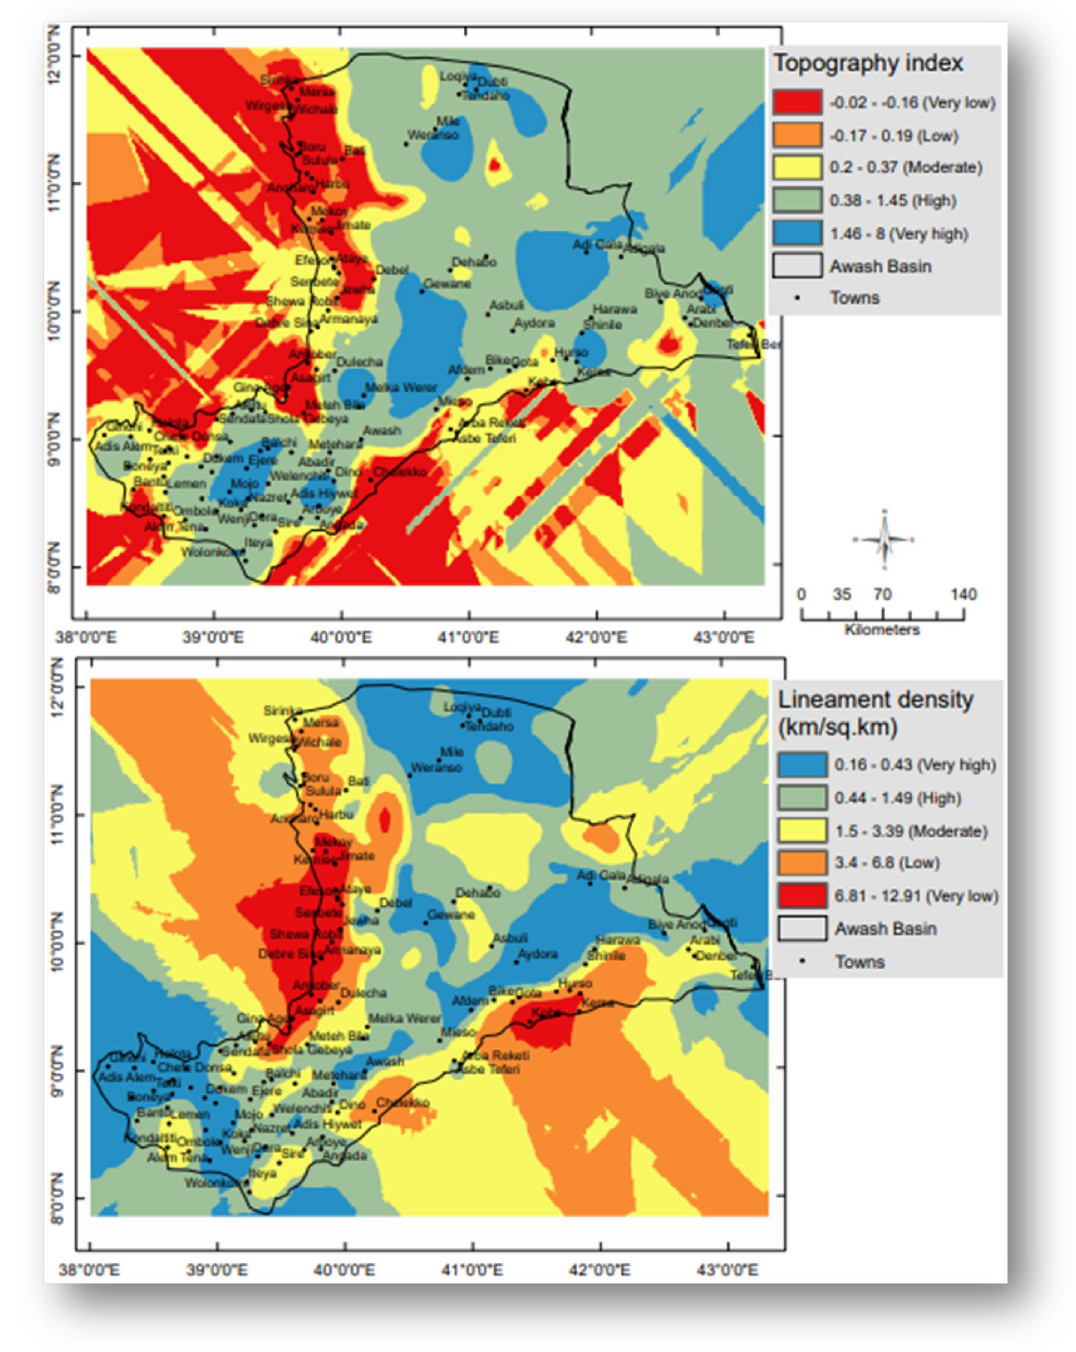
Figure 6. Weighted topographic wetness index and lineament density of the Awash basin, Ethiopia. This figure was created using ArcGIS 10.3.1